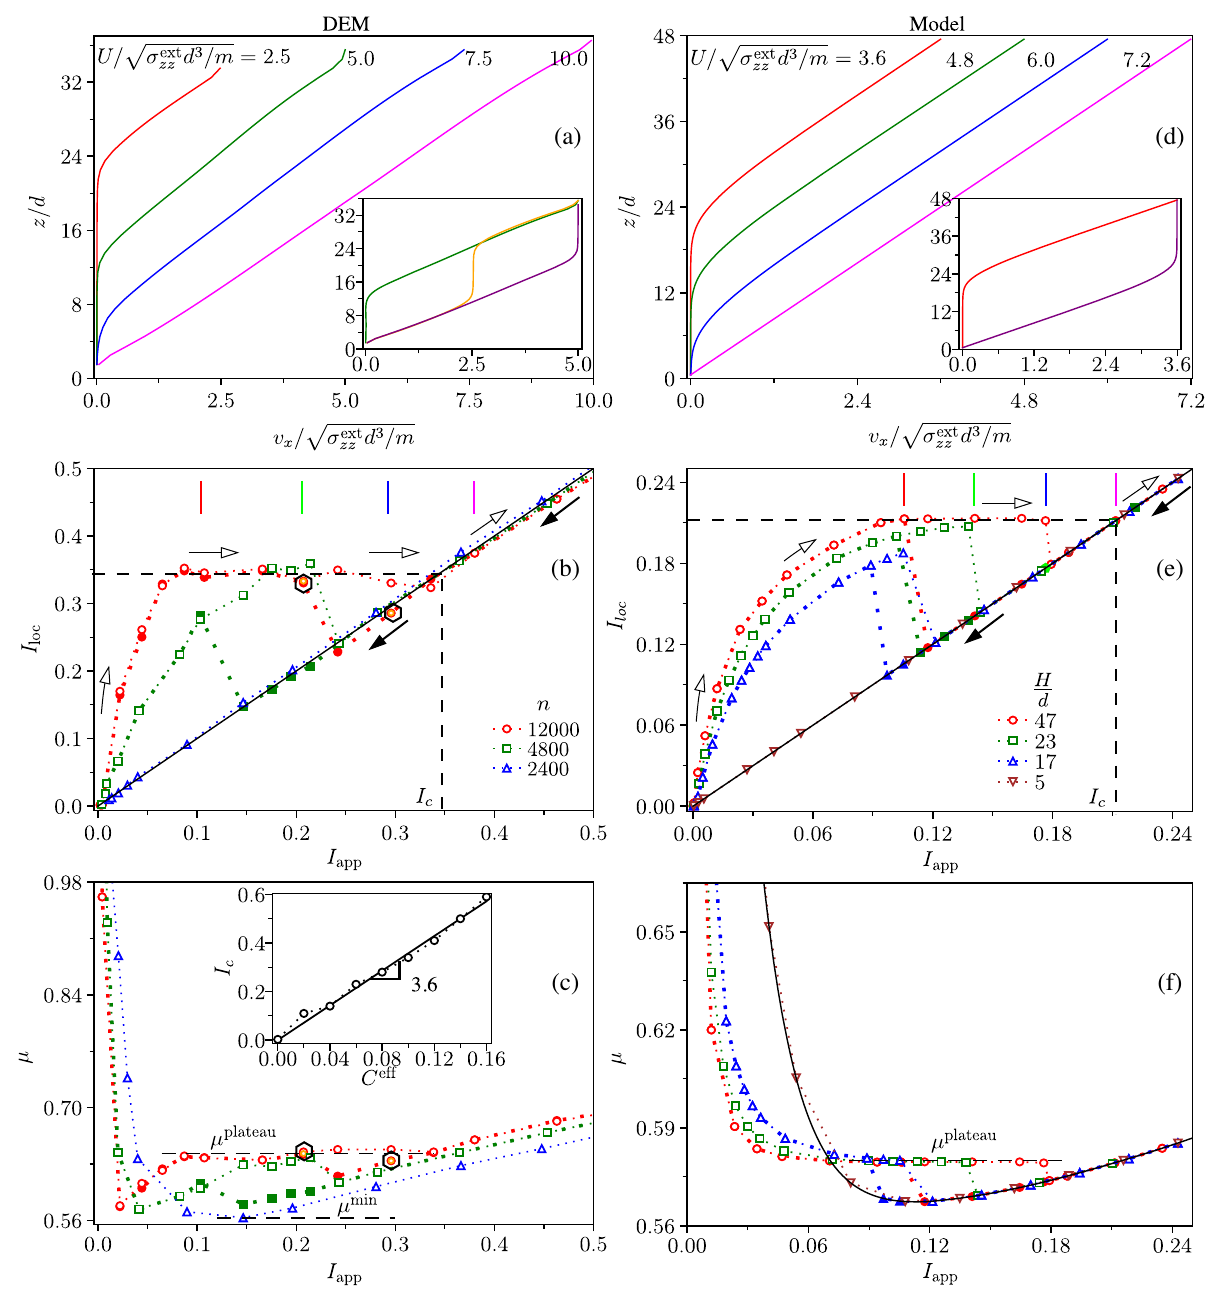
FIG. 4. Shear-banded flow regime in discrete (left-hand column) and continuum (right-hand column) simulations. (a) Evolution of the steady shear-banded velocity profile v x ð z Þ with increasing U , following the steady shear rate up sweep, for C eff ¼ 0 . 1 and ( n ¼ 12 000 . Inset in (a): velocity profiles, obtained following different shearing protocols; (left) the steady shear rate up sweep, (middle) the shear rate jump, (right) the steady shear rate down sweep. (b) The local inertial number I as a function of the apparent inertial number I loc app for different system sizes ( n ) for C eff ¼ 0 . 1 . Data for very high I are not shown for clarity. Data are extracted from steady v x ð z Þ , app obtained following the steady shear rate up sweep (open symbols) and the steady shear rate down sweep (filled symbols). Orange hexagons enclosed in black hexagons correspond to the data obtained following the shear rate jump. Vertical lines in different colors, aligning with circular symbols, correspond to the data for the velocity profiles of the respective color shown in (a). The arrows give the directions for the sweep. The dashed lines indicate the value of the critical inertial number I c above which a fully developed flow is established for the largest system ( n ¼ 12 000 ). (c) Friction coefficient μ ð I for the same simulations as in (b). The plateau in μ , app Þ C eff . The μ plateau , and the minimum of the intrinsic rheological curve, μ min , are indicated by dashed lines. Inset in (c): I c as a function of solid line is a linear least-squares fit to the data with a slope of 3.6. (d) – (f) Similar plots as in (a) – (c) from the continuum simulations, I Þ [solid line in (f)] measured in DEM for C eff ¼ 0 . 1 , n ¼ 2400 obtained for β ¼ 1 , introducing the intrinsic rheological curve μ int ð